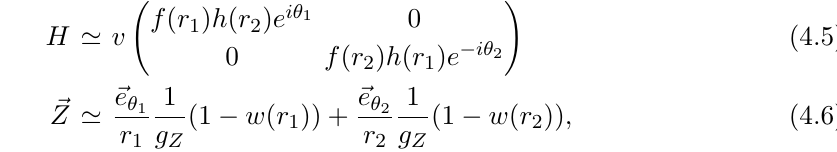
FIG. 1: Single vortex configurations 2 (broken line)) on a cross section. and Ψ 2 | |